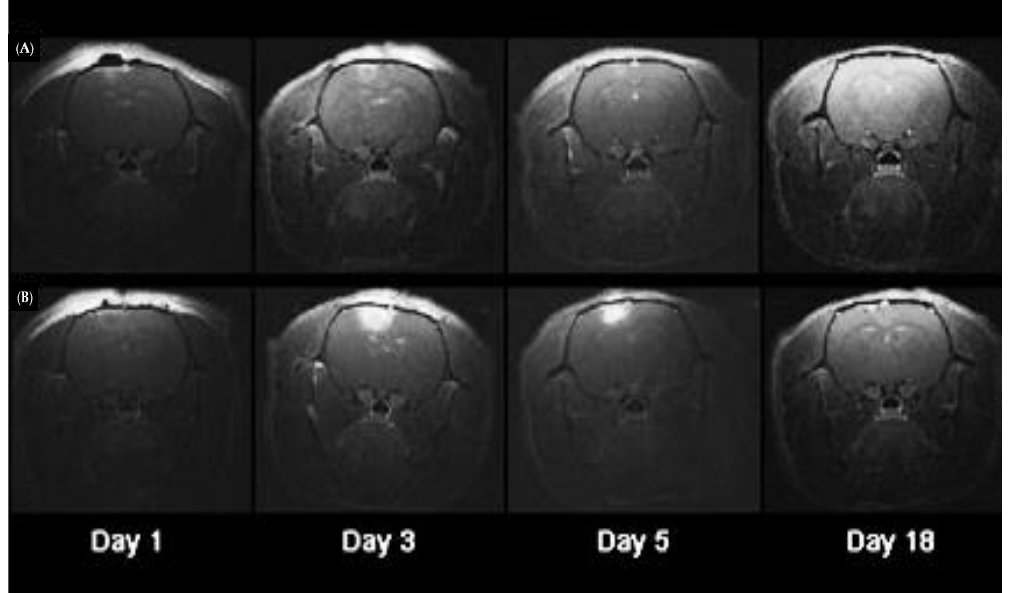
Figure 5. Comparison of T1-weighted post contrast MRI scans after PDT and PCI treatment. ( A ) The PDT treated animal received a light fluence of 1 J; ( B ) the PCI treated animal received a light fluence of 1 J and an i.p. injection of Cl p at a concentration of 1:100. Both animals were scanned on days 1, 3, 5 and 18 after treatment. All T1 post contrast images were taken 15 min following i.p. contrast injection.